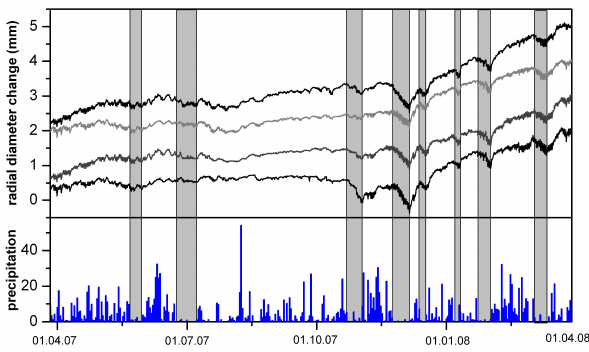
Fig. 5. Stem diameter variations of four Cedrela trees in south- ern Ecuador (upper panel) and daily sums of precipitation (lower panel). Longer periods without rainfall that occur during the leafy season of Cedrela are marked by grey bars. During roughly August to November, Cedrela is partly shedding the leaves (Br¨auning et al.,